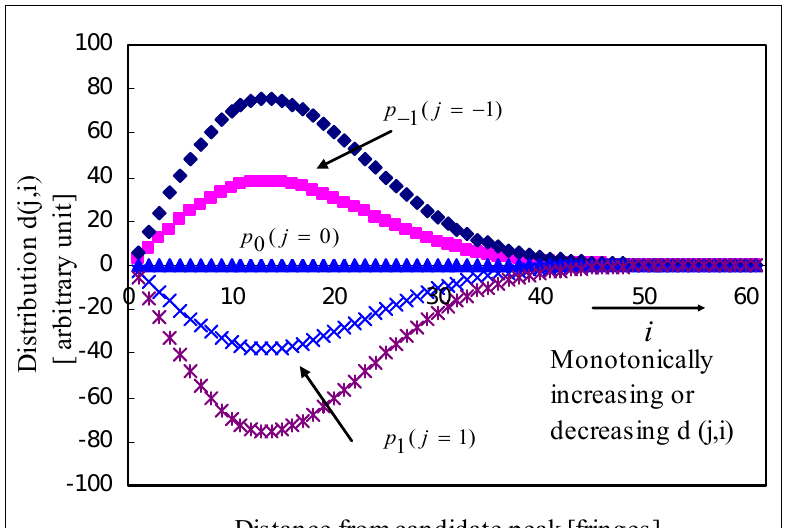
Figure 7 . Distribution ),( ijd of noise-free